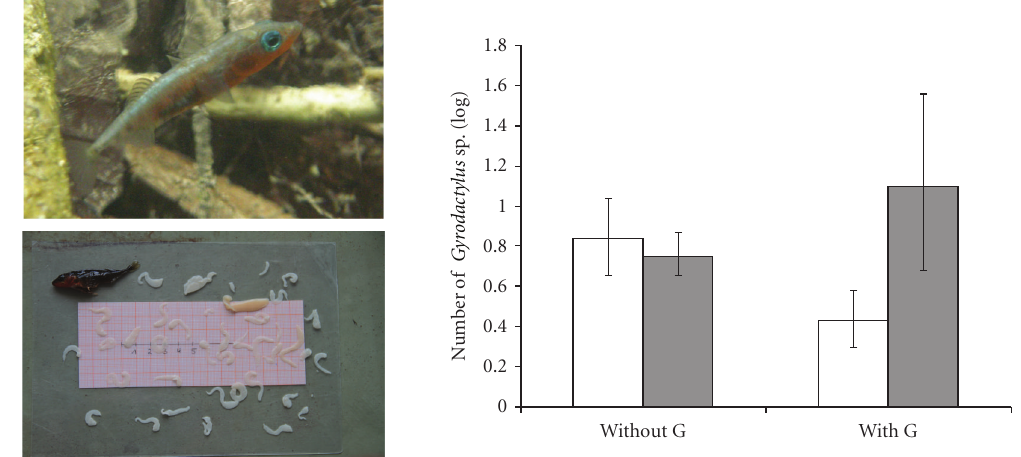
Figure 4: Top left: a nuptial male of a lake ecotype of the Three-spined stickleback ( Gasterosteus aculeatus species complex, photo Ole Seehausen). Bottom left: a breeding male stickleback and a series of Schistocephalus cestodes that were found in its body cavity (photo courtesy of Kay Lucek). These tapeworms change the behaviour of stickleback and e ff ectively castrate them. Right: mean number of ectoparasitic Gyrodactylus monogenean parasites (log transformed) on Schleswig Holstein lake (grey bars) and river (white bars) sticklebacks, with or without an MHC haplotype G. Occurrence of the haplotype coincides with higher resistance against the parasite in the river ecotype while there is a tendency for the opposite pattern in the lake ecotype. Figure produced with permission from data in Eizaguirre et al.